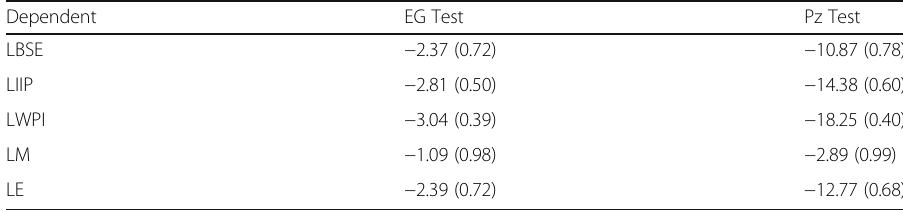
Table 2 Conventional Cointegration